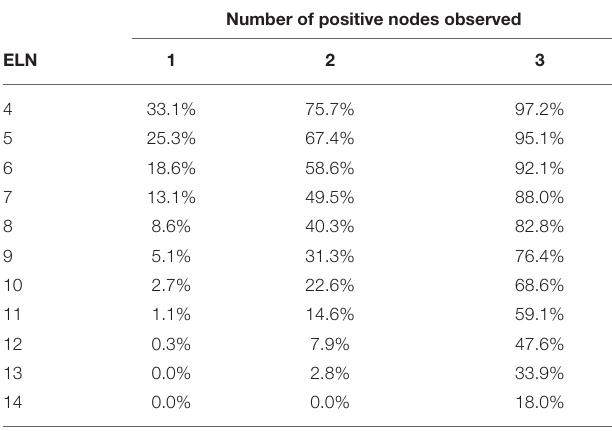
TABLE 5 | Probability of 4 or more positive lymph nodes in patients with T1 tumor.